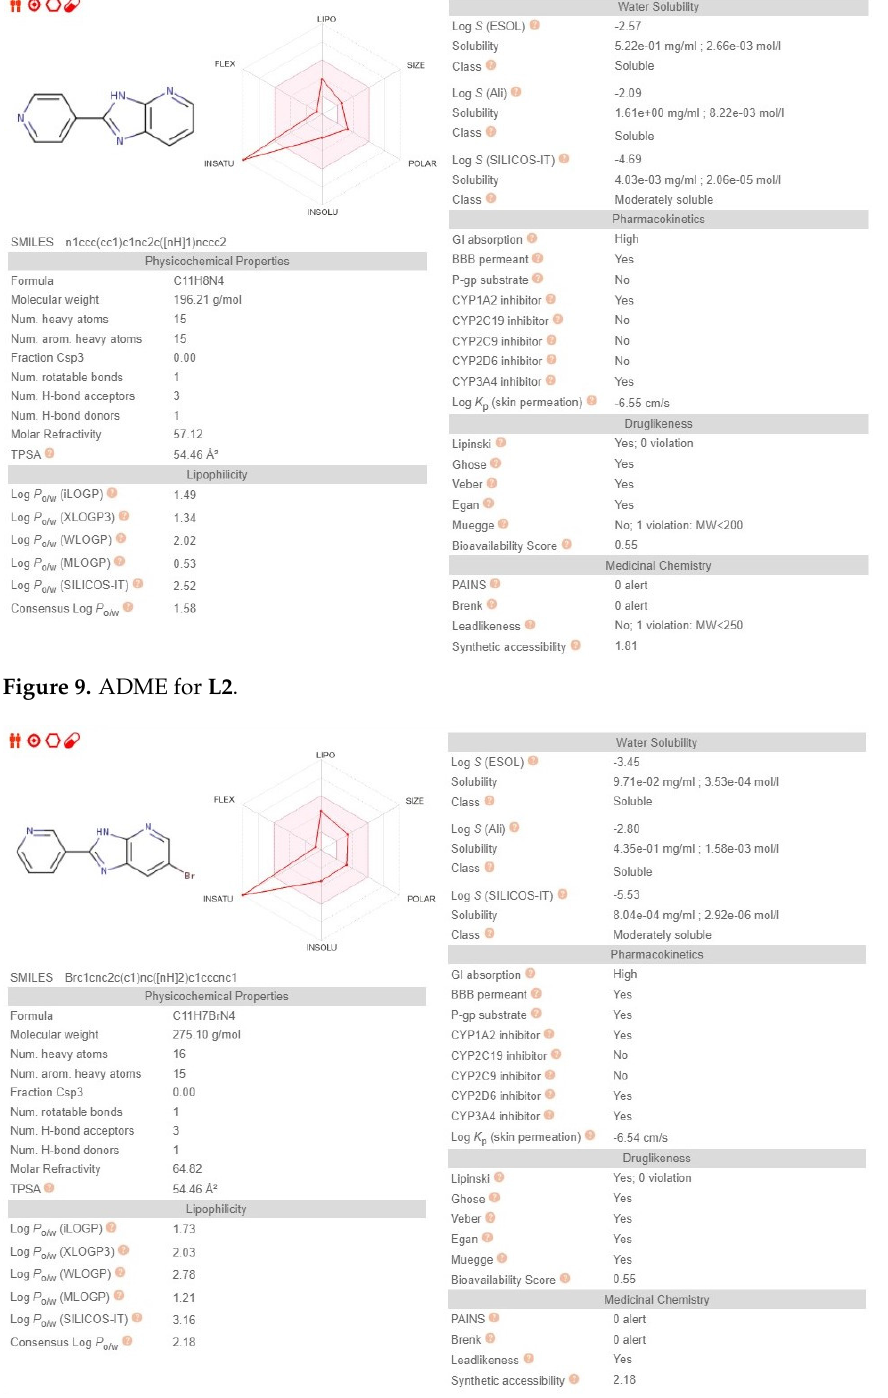
Figure 10. ADME for L4 .